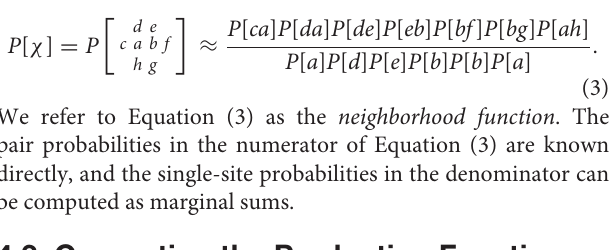
are available (i.e., non-refractory). Then the probability that any one of them will recruit the site is given by (1 − αγ ) n